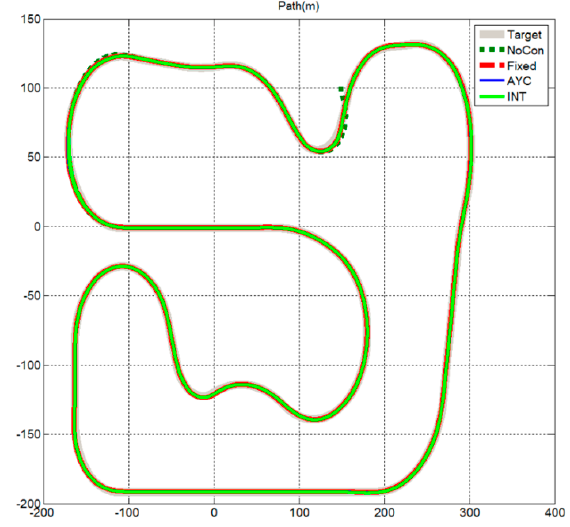
Figure 12. Target path and driving path for complex road.